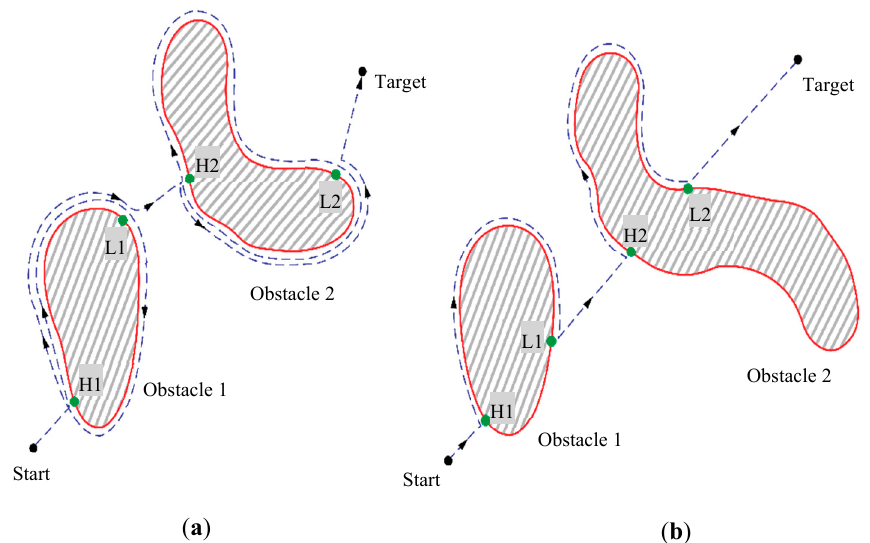
Figure 9. Trajectories of the Bug1 ( a ) and Bug2 algorithms ( b ) [288].